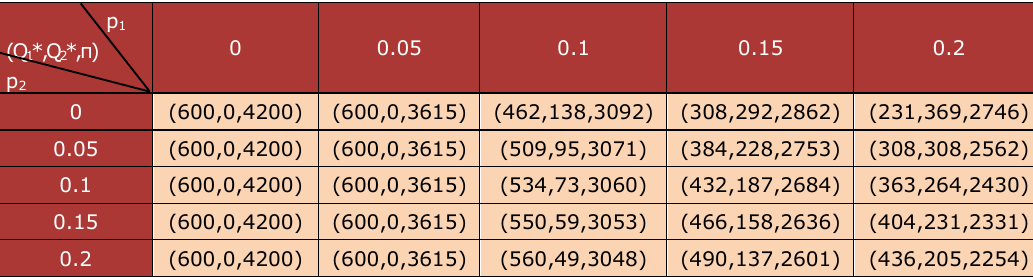
Table 1. Optimal ordering quantity and total weighted expected profit based on p 1 and p 2